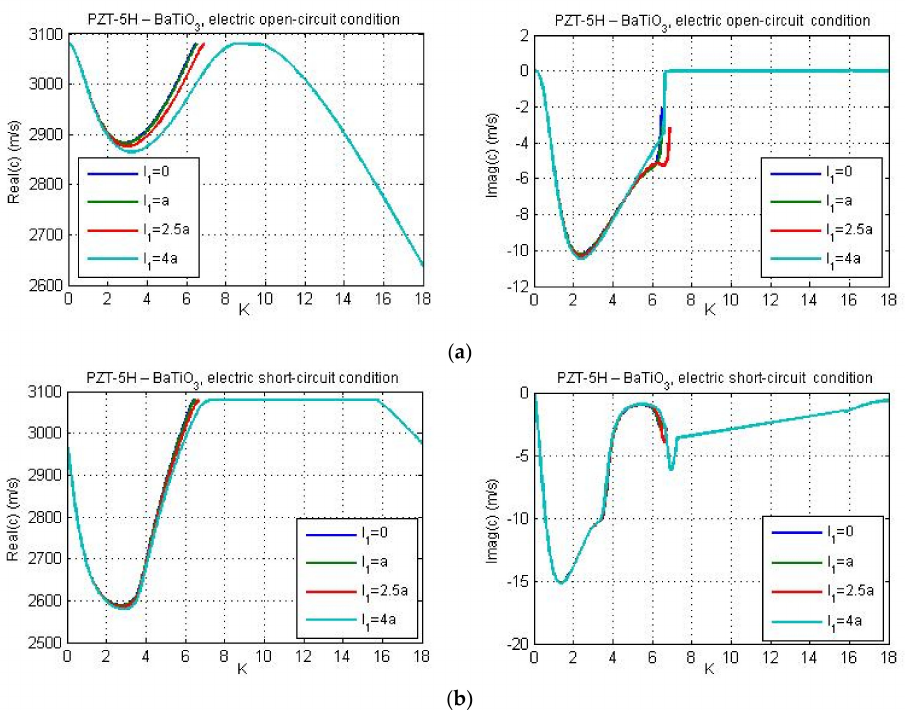
Figure 7. The real and imaginary parts of phase velocity c versus non-dimensional wave number K for various micro-inertia characteristic lengths; ( a ) electric open-circuit conditions and ( b ) ) electric short-circuit conditions.